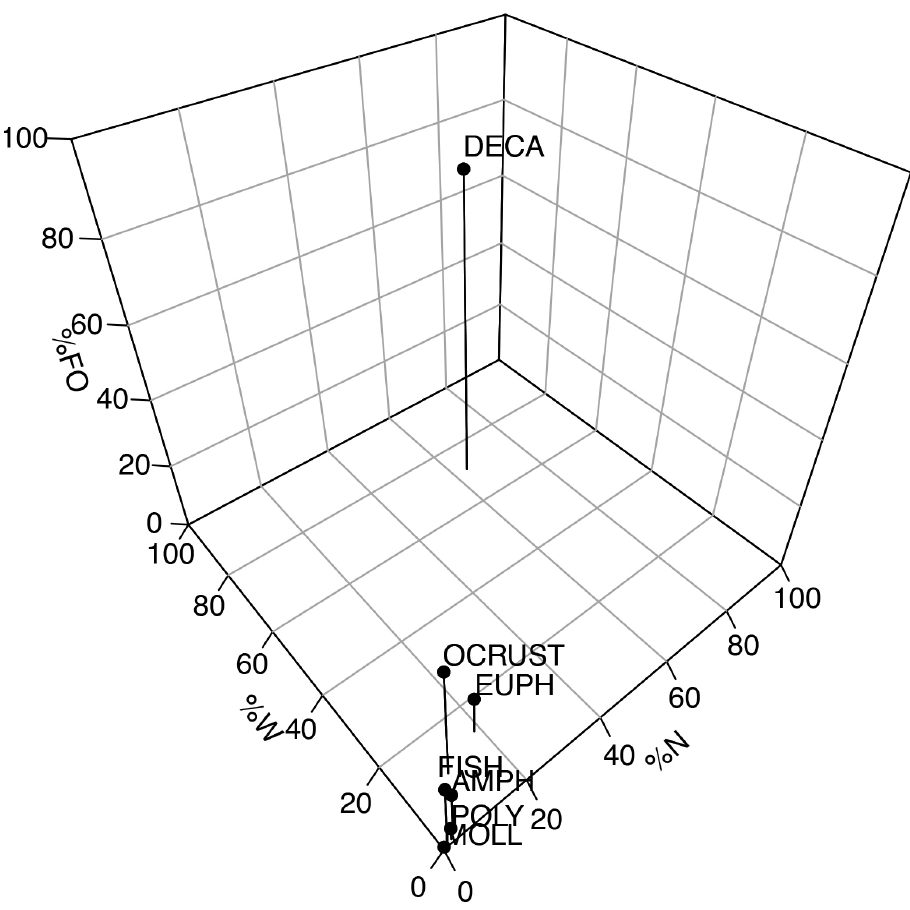
FIGURE 4 | Three-dimensional graphical representation of the percentage number, percentage weight, and percentage frequency of occurrence of the major taxa in the diet of Urotrygon microphthalmum. Food items grouping follow as proposed by Ebert, Bizzarro (2007). DECA: Decapod crustaceans; OCRUST: Other crustaceans and unidentified crustaceans; EUPH: Euphasiids and mysids; FISH: Teleost fishes; AMPH: Amphipods and isopods; POLY: Polychaetes and other marine worms; MOLL: Molluscs (excluding cephalopods) and unidentified